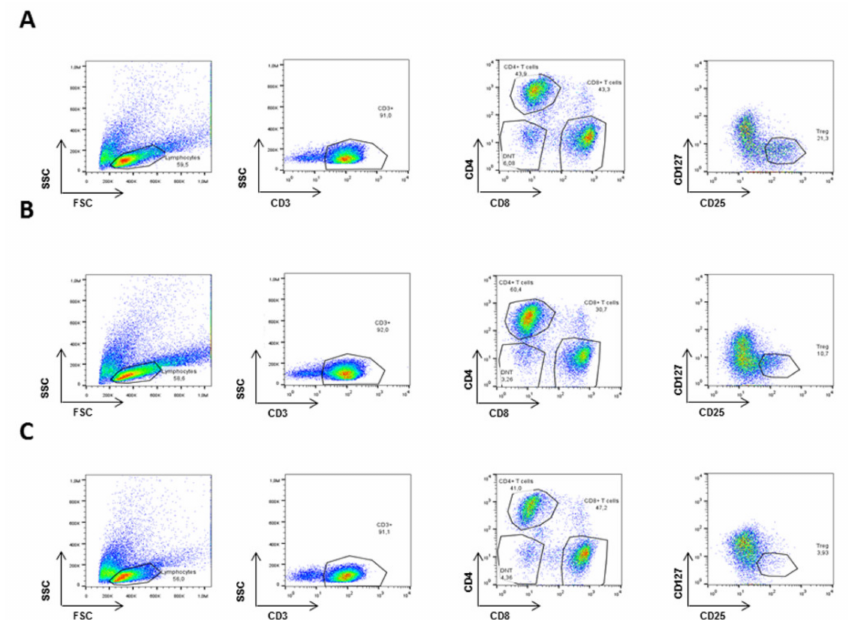
Figure 2. Gating strategy for T cell analysis. PBMC isolated from the peripheral blood of healthy donors, were activated for 24 h with Concanavalin and were cultured alone ( A ) or co-cultured with ARPCs ( B ) or with LTA-activated ARPCs ( C ) for 5 or 15 days and analyzed by flow cytometry. The fig- ure is representative of one experiment showing the gating strategy used to identify lymphocytes (left panel), CD3 + T cells and T cells subsets: CD4 + T cells, CD8 + T cells, DN T cells and